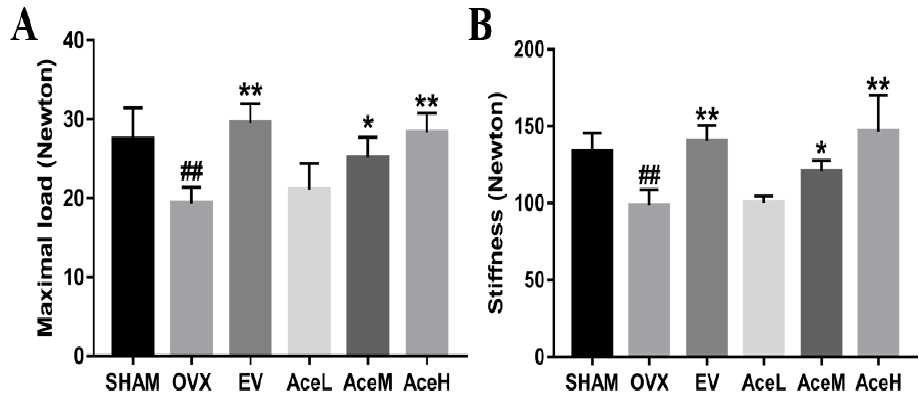
Figure 2. Effects of acteoside and EV on OVX-induced bone biomechanical changes of mice measured by using a three-point bending test ( n = 4); ( A ) Maximal load. ( B ) Stiffness. Values are presented as the mean ± SD; * p < 0.05, ** p < 0.01 relative to the mice of OVX model group; ## p < 0.01 relative to the SHAM mice.